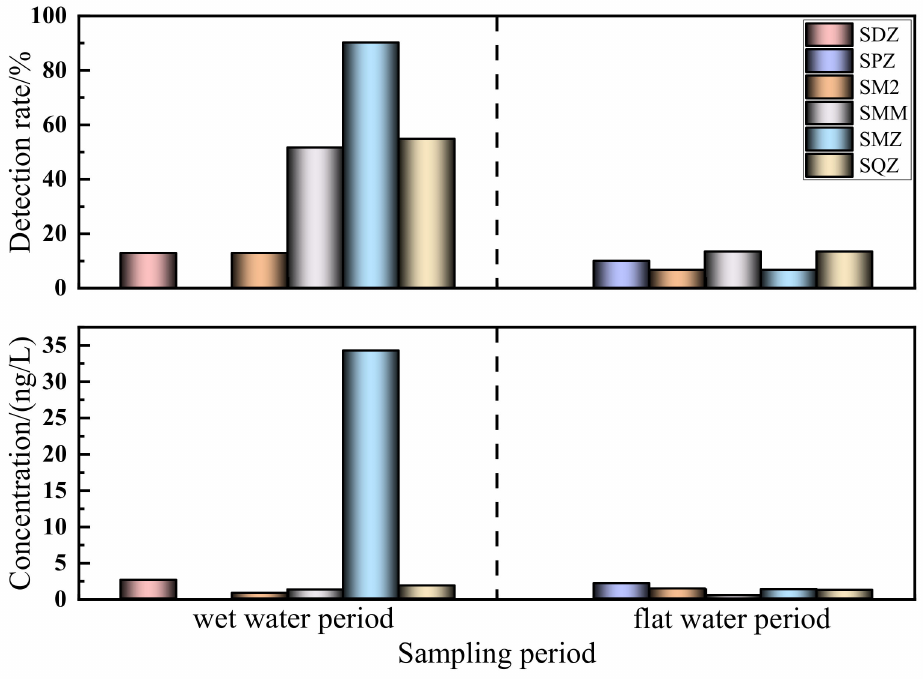
Figure 4. Seasonal distribution of SAs detection rate and concentration in the Shaanxi section of the Weihe